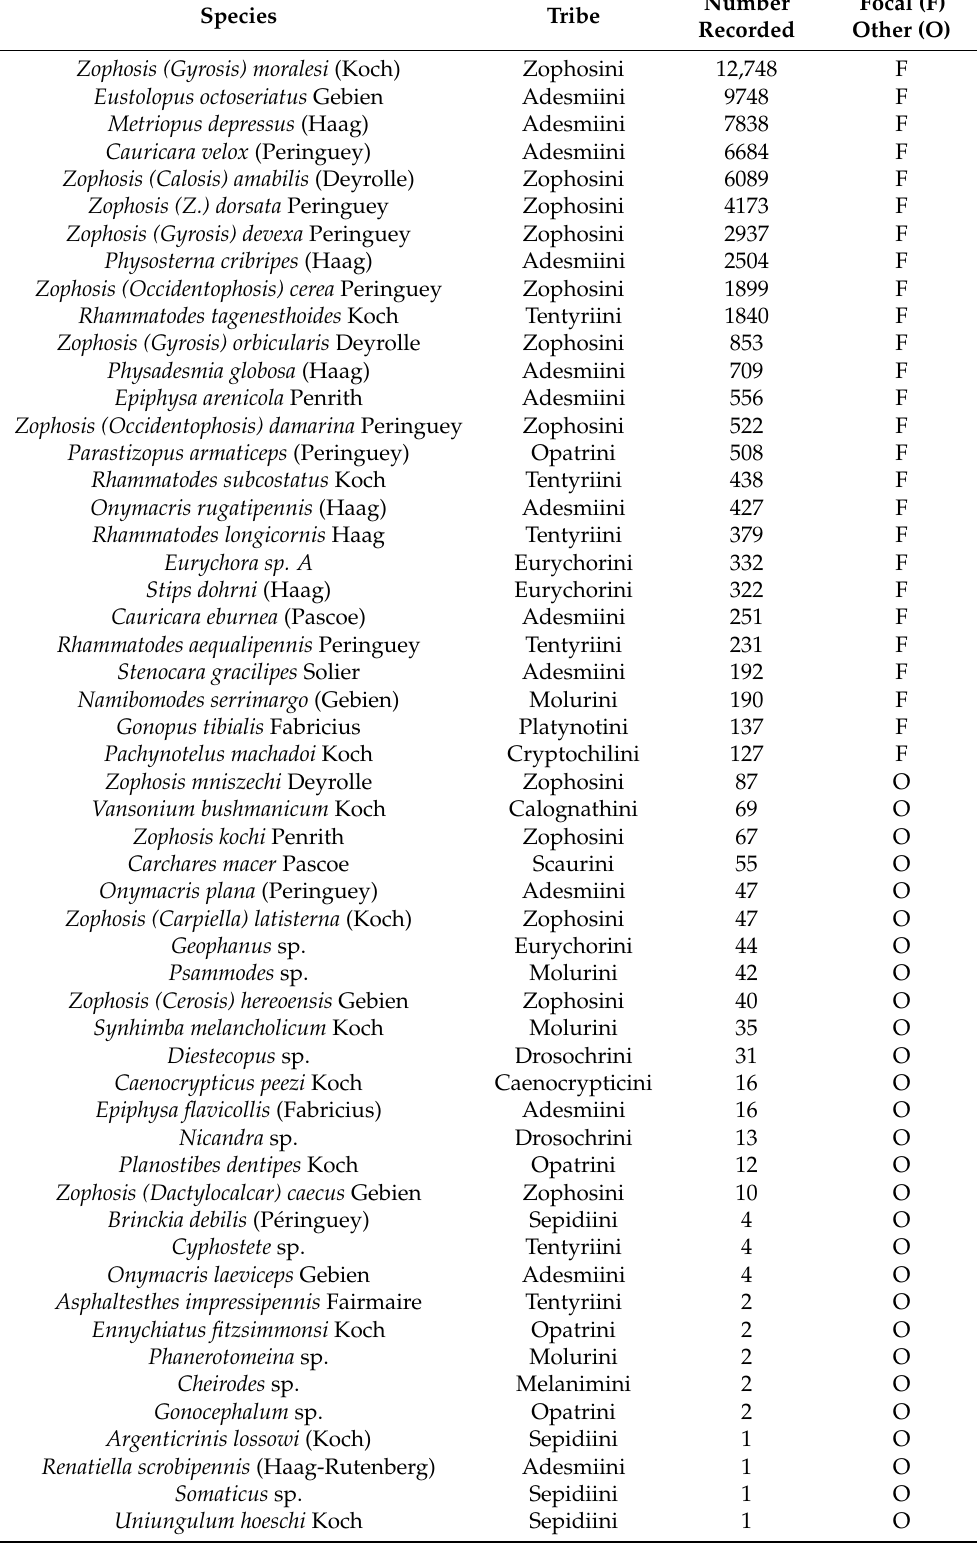
Table A1. Tenebrionid focal species (F) and others (O) pitfall trapped at the Namib gravel plain study site between 1976 and 2020. Data source: Gobabeb Namib Research Institute